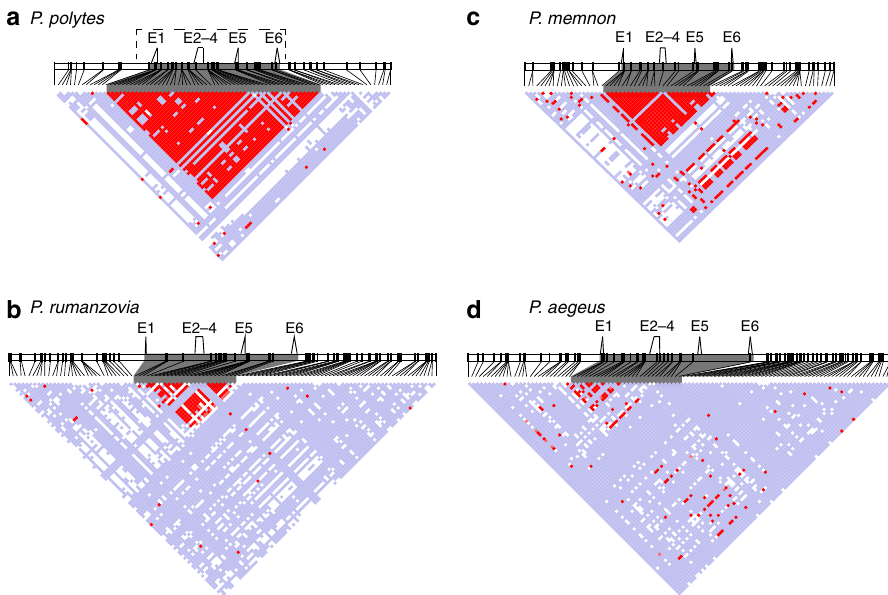
Fig. 4 Linkage disequilibrium (LD) heat maps. LD across dsx (gray shading) and fl anking 100 kb for P. polytes ( a ), P. rumanzovia ( b ), P. memnon ( c ), and P. aegeus ( d ). Standard color scheme: D ’ < 1, LOD < 2 (white); D ’ = 1, LOD < 2 (blue); D ’ ≤ 1, LOD ≥ 2 (pink and red). Dashed line in a shows the inverted region. E1 – 6 indicate the dsx